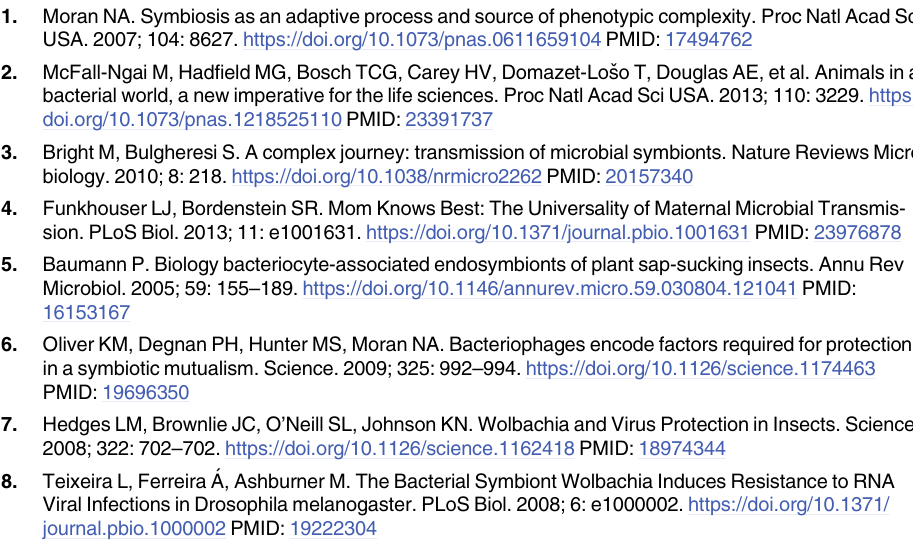
S6 Table. SNP density and repeat proportion of the 25,196 contigs and scaffolds of the A . nasatum genome assembly. SNP, single nucleotide